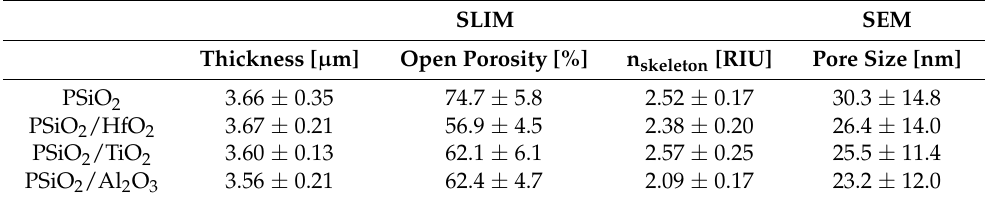
Table 2. Thickness, open porosity and n skeleton of the sensing layer of the passivated PSi membranes, evaluated by the SLIM method. Pore size was evaluated through SEM image